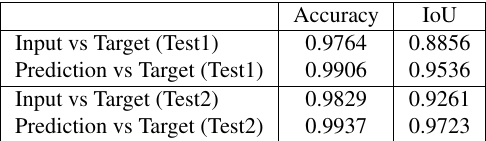
Figure 9. Buildings shown in original size of scale 1:15.000